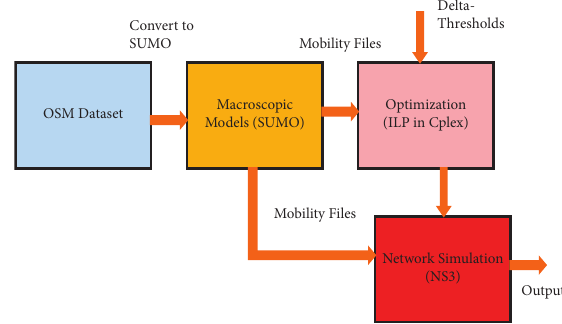
Figure 1: The architecture of RSUs deployment